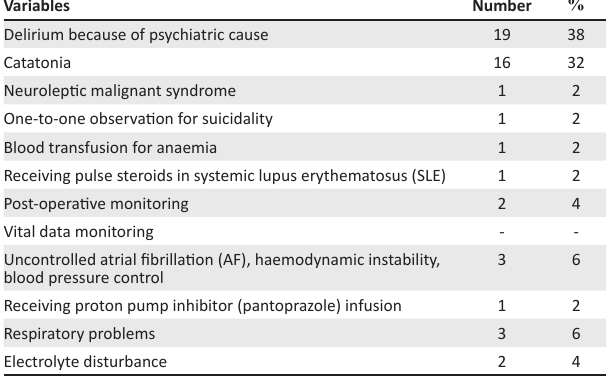
TABLE 2: Causes of admission.